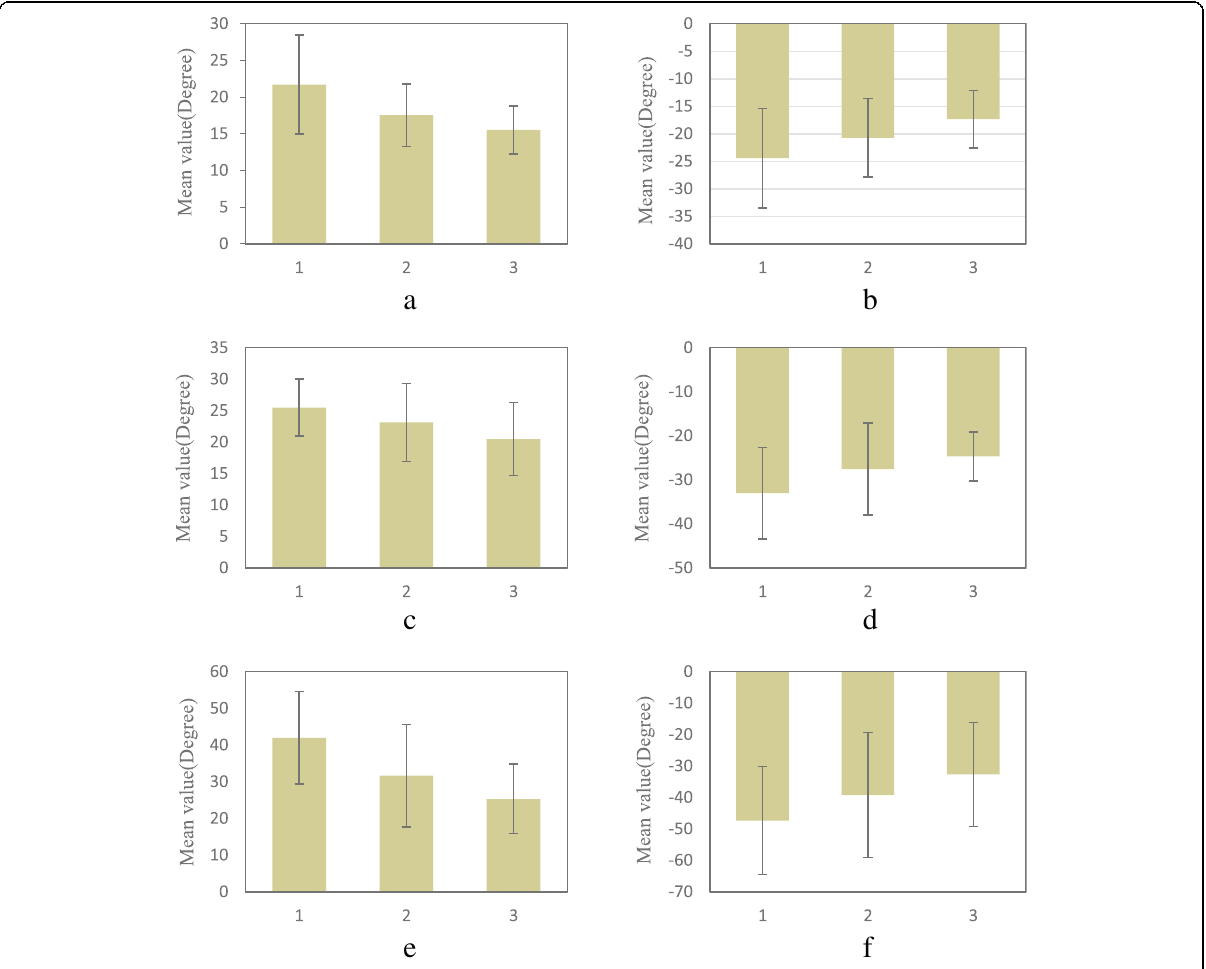
Fig. 11 Bar graph of the operating range in six motion directions with three grades of avatar speed. a X+. b X − . c Y+. d Y − . e Z+. f Z